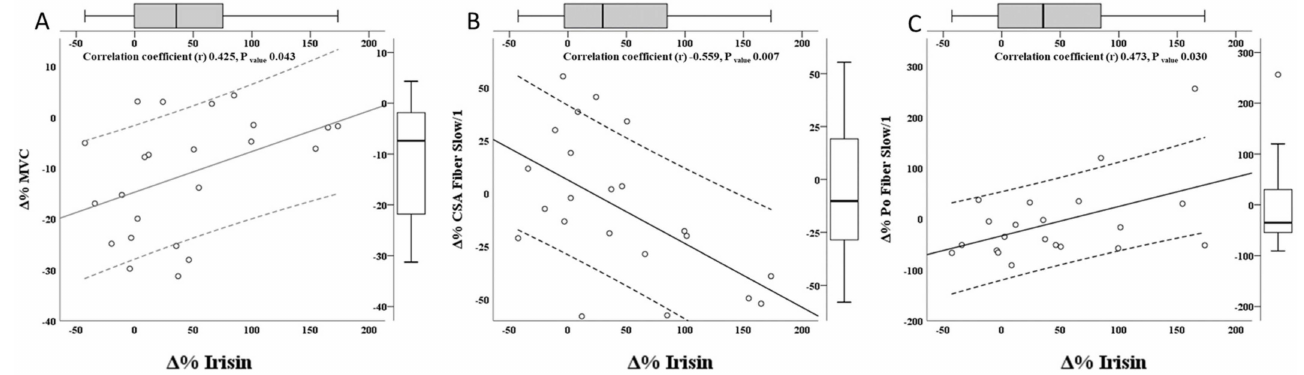
Figure 2. Correlation analysis between Irisin variation (percentage difference of the variables between BR14 and BDC) and fiber types properties variation (percentage difference of the variables between BR14 and BDC). In the different panels are described correlations between ∆ Irisin (mg/L) BR14 vs. BDC (%) and ( A ): ∆ MVC (%); ( B ): ∆ CSA Fiber Slow/1(%); ( C ): ∆ P 0 Fiber Slow/1. BDC, baseline data collection; BR14, after 14-day Bed Rest data collection; ∆ % variable, percentage difference of the variables of interest between BR14 and BDC; MVC, maximal voluntary contraction; CSA, cross-sectional area; P 0 , specific